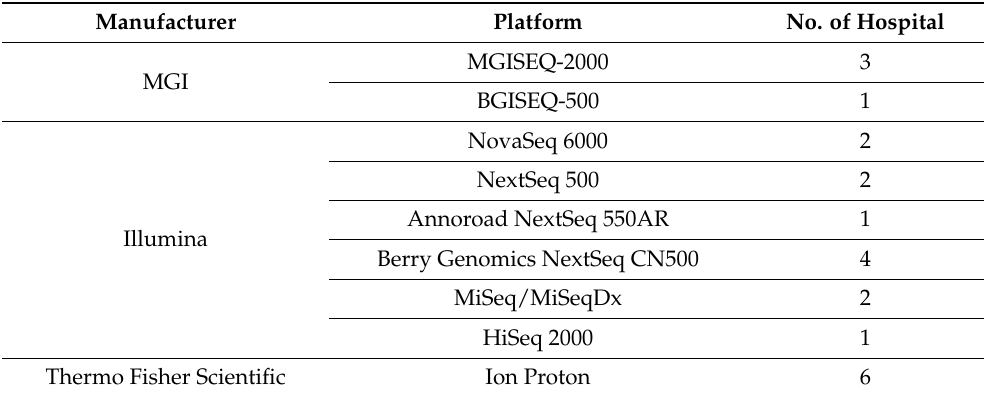
Table 2. Sequencing platforms and manufacturers utilized by 21 Chinese tertiary hospitals in this survey.